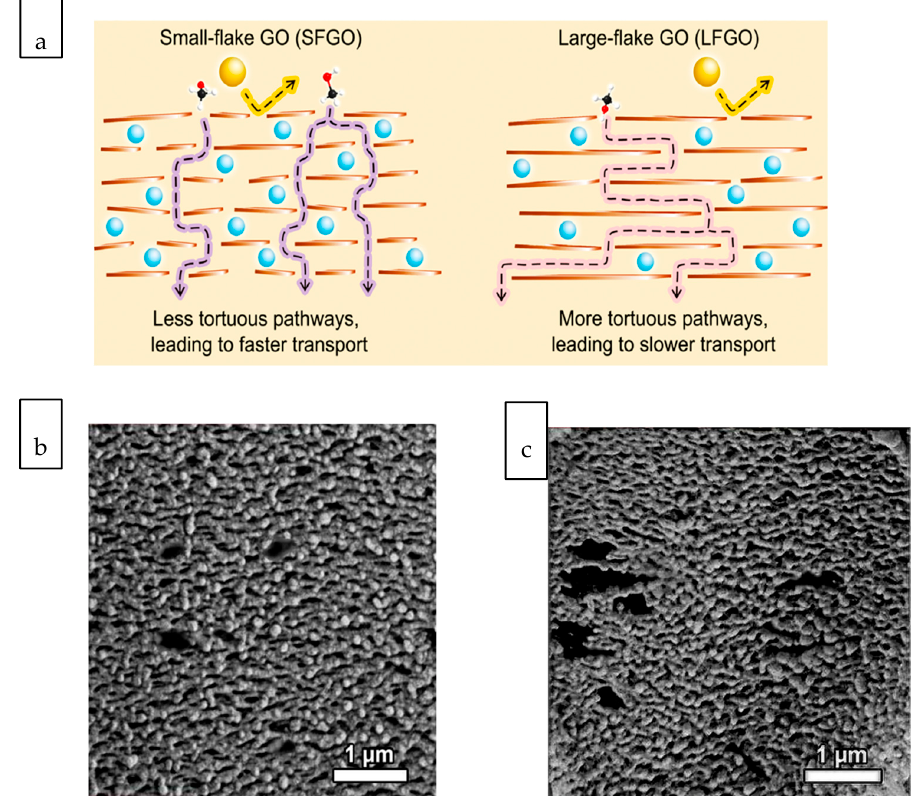
Figure 4. ( a ) Schematic illustration of solvent molecule transport pathway in small-flake graphene oxide (GO) and large-flake GO with different lateral [133], cross-sectional images of polyethersulfone (PES) support layers templated with ( b ) ZnO nanoparticles and ( c ) ZnO nanorods [134].